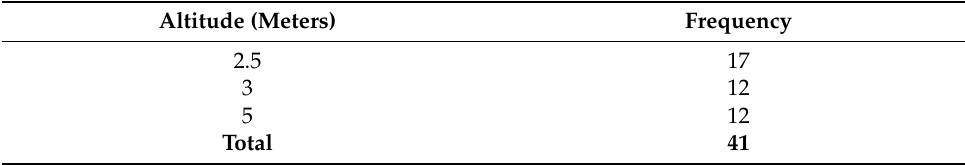
Table 1. Number of images captured for each flight